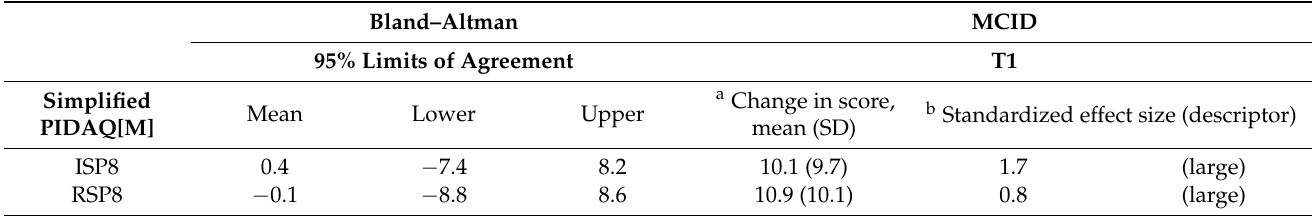
Table 3. The MCID of the simplified PIDAQ[M] forms following orthodontic treatment.